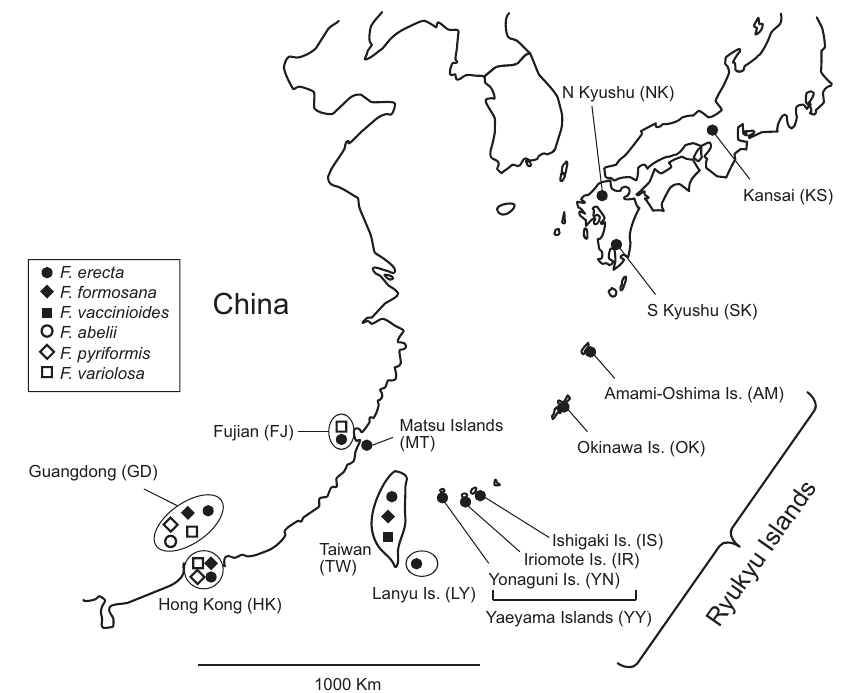
Fig. 1 Sampling locations of fi gs and their pollinator wasps used in this study. The abbreviations of population names are given in parentheses and correspond to those used in other fi gures and Tables. Table 1 Samples and molecular data used in this study. Host fi gs Species